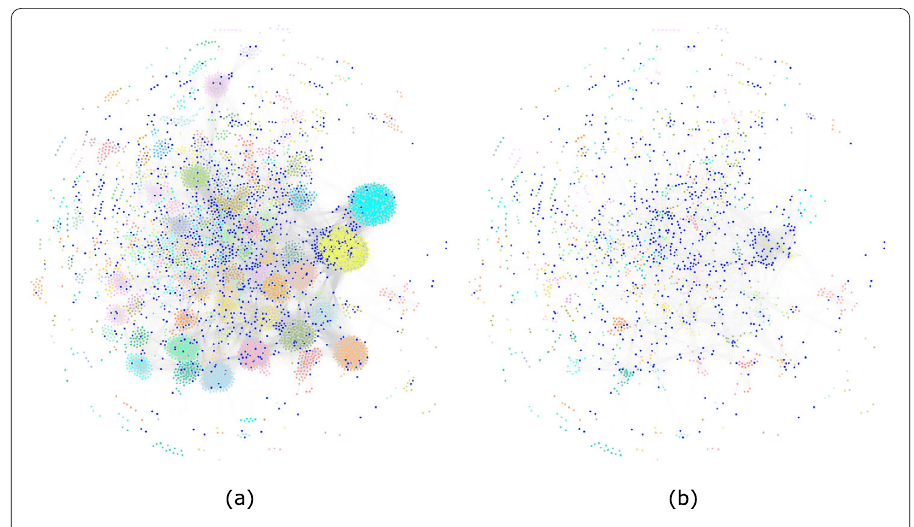
Figure 3 Subfigures illustrate the ( a ) network with all insiders and ( b ) the insider network only with matched insiders. The node colors differentiate insiders’ companies except for the dark blue